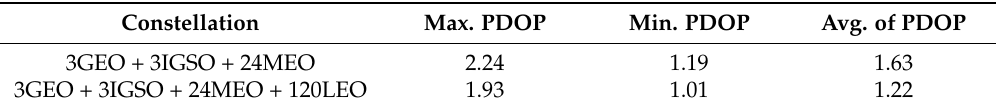
Table 6. Statistical results for